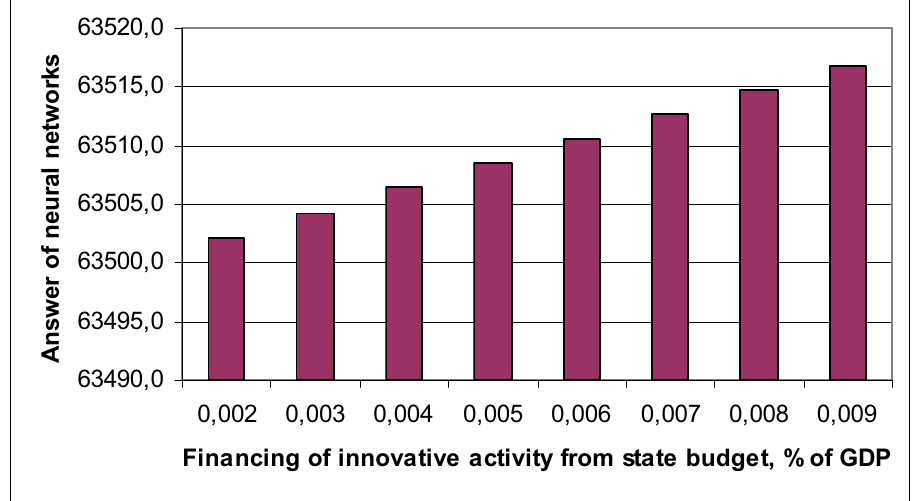
Fig. 4. The influence of the innovative activity financing from the national budget over GDP of the country